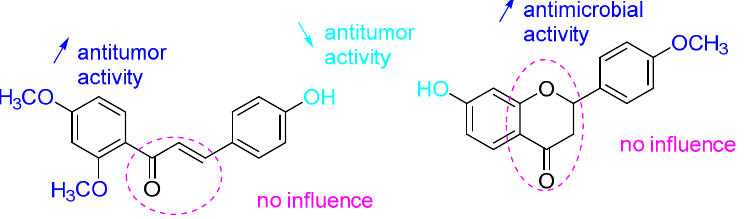
Figure 7. Structure/activity relationships established for antitumor activity. Figure 7. Structure / activity relationships established for antitumor